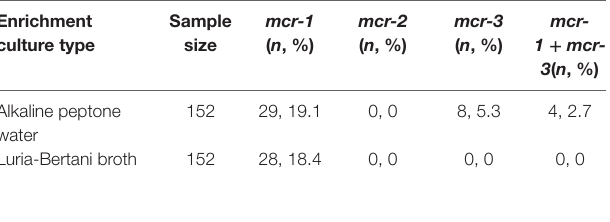
TaBle 1 | Initial polymerase chain reaction screening results for the presence of mcr genes in enrichment stool cultures.